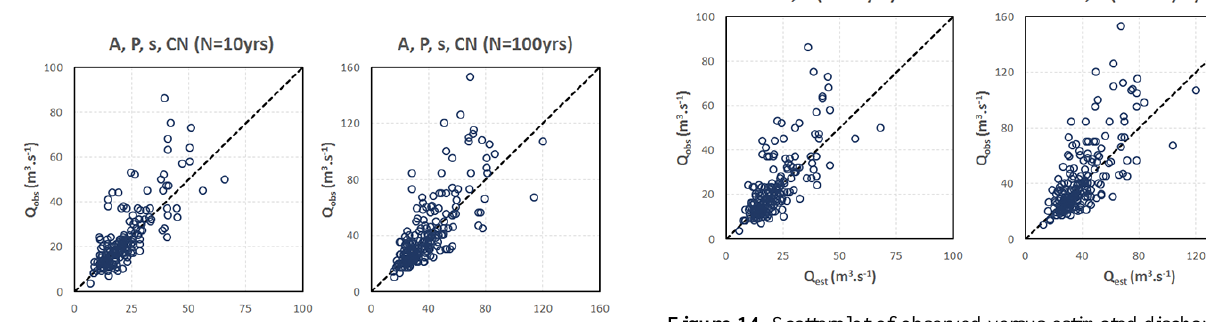
Figure 14. Scatterplot of observed versus estimated discharge val- ues for a combination of catchment area and maximum daily precip- itation total for T = 10 years (left panel) and T = 100 years (right